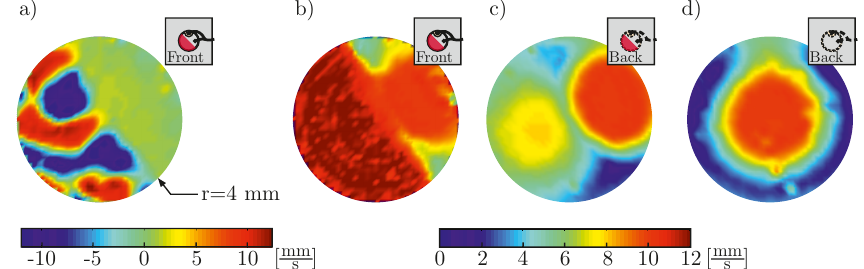
Figure 6. Velocity fields for a PWAS with 50% debonding: ( a ) At the top of the transducer, the velocity field at a given time step after the decay of the input signal shows the trapped energy; ( b ) While the maxima of the velocity field from the top show maximum values in the area of the debonding, where the PWAS can vibrate freely; in ( c ) it is shown, that this energy is not transferred into the structure; ( d ) For comparison, the maxima of the velocity field from the back for a fully bonded PWAS show almost symmetric